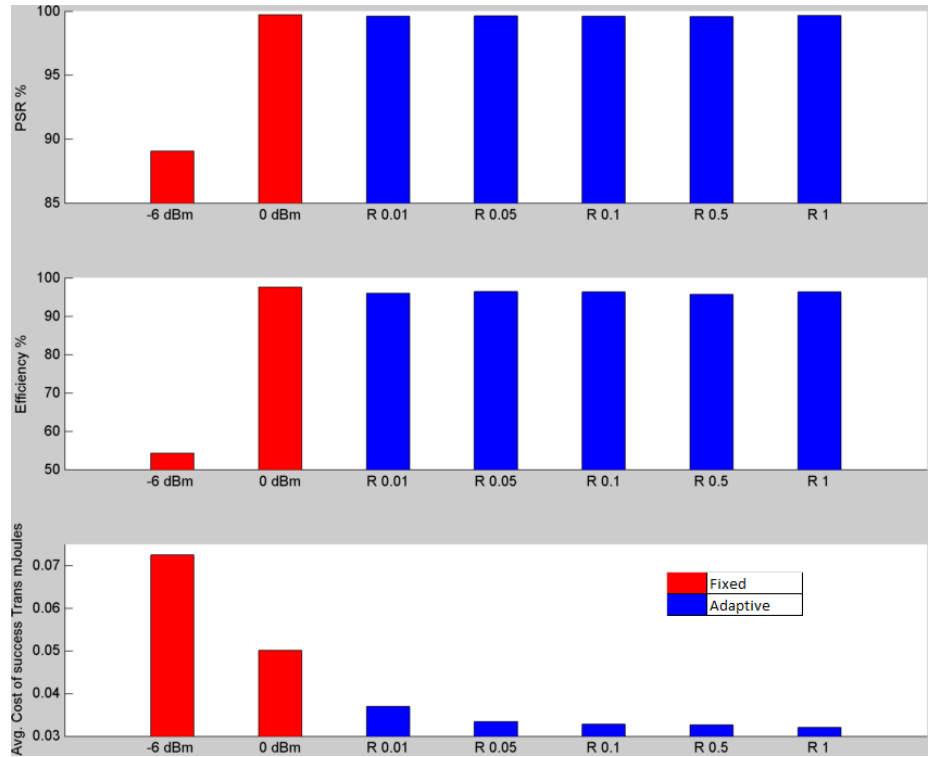
Figure 5. Comparison of the efficiency and average cost of successful transmission based on the PSR when the distance between the sensor and the hub is 20 m. The minimal cost of fixed power transmission is achieved at 0 dBm. In this case the PSR of fixed power at 0 dBm is same as the PSRs of adaptive protocol. In terms of energy efficiency, the adaptive protocol consumes 55% less energy than the fixed power transmission at 0 dBm when R = 1. The efficiency of the fixed power transmisison is a touch higher than that of the adpative protocol at R =